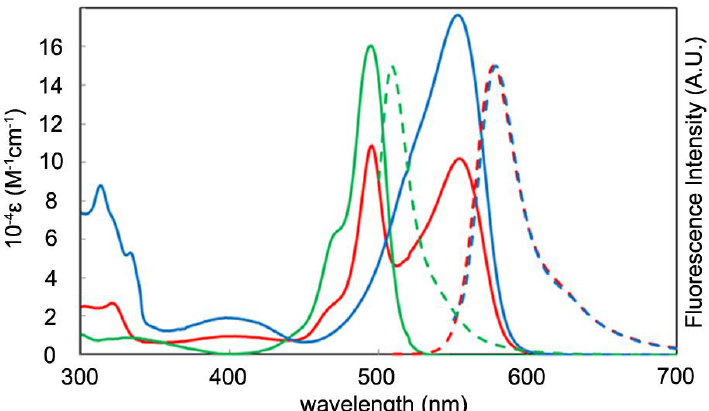
Figure 18. Absorption and emission spectra for 2a , 3a , and 4 in toluene.